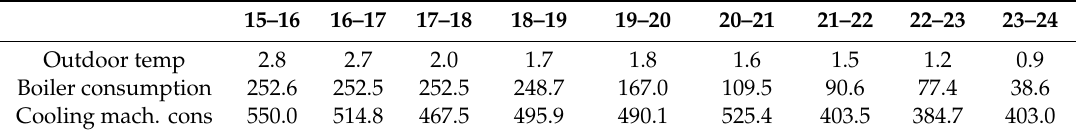
Table 12. Updated forecasts for the rest of the day before iteration